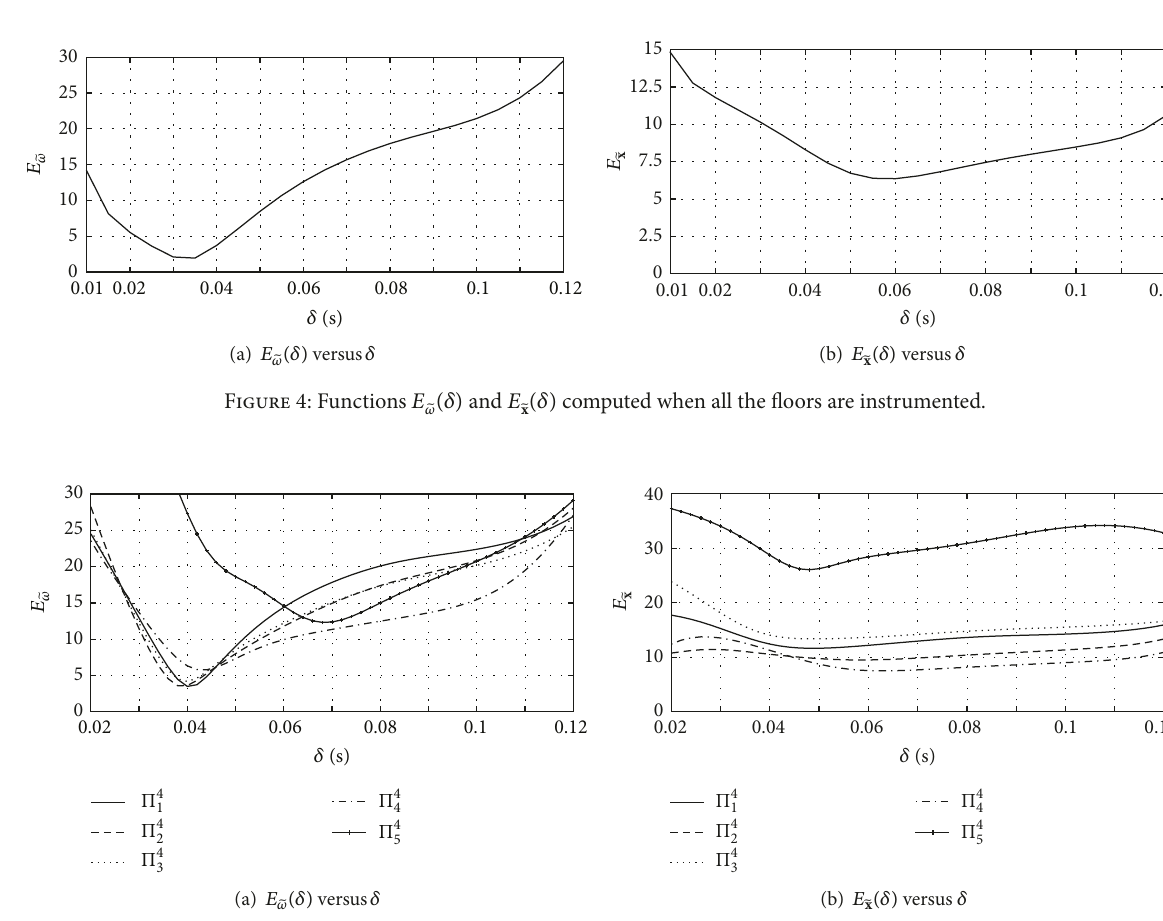
Figure 5: Functions 𝐸 ̃𝜔 (𝛿) and 𝐸 ̃ x (𝛿) computed with four instrumented